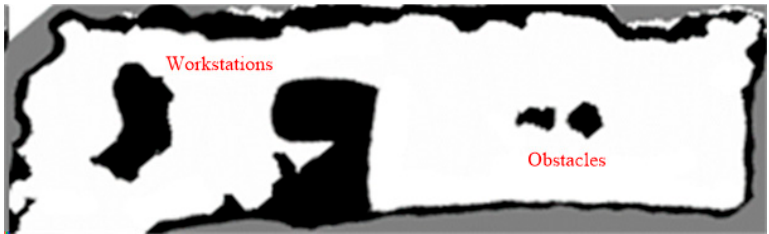
Figure 8. The obtained map of Area 1.